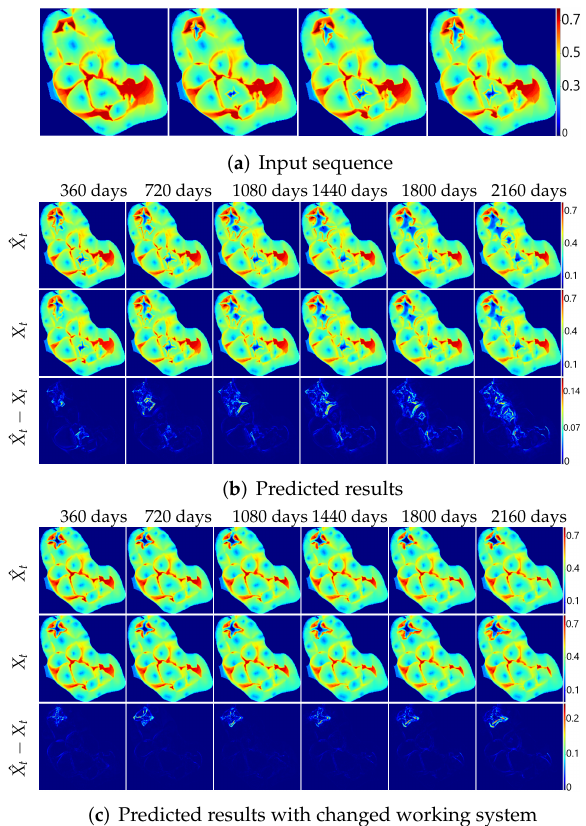
Figure 7. Prediction examples on different injection–production working